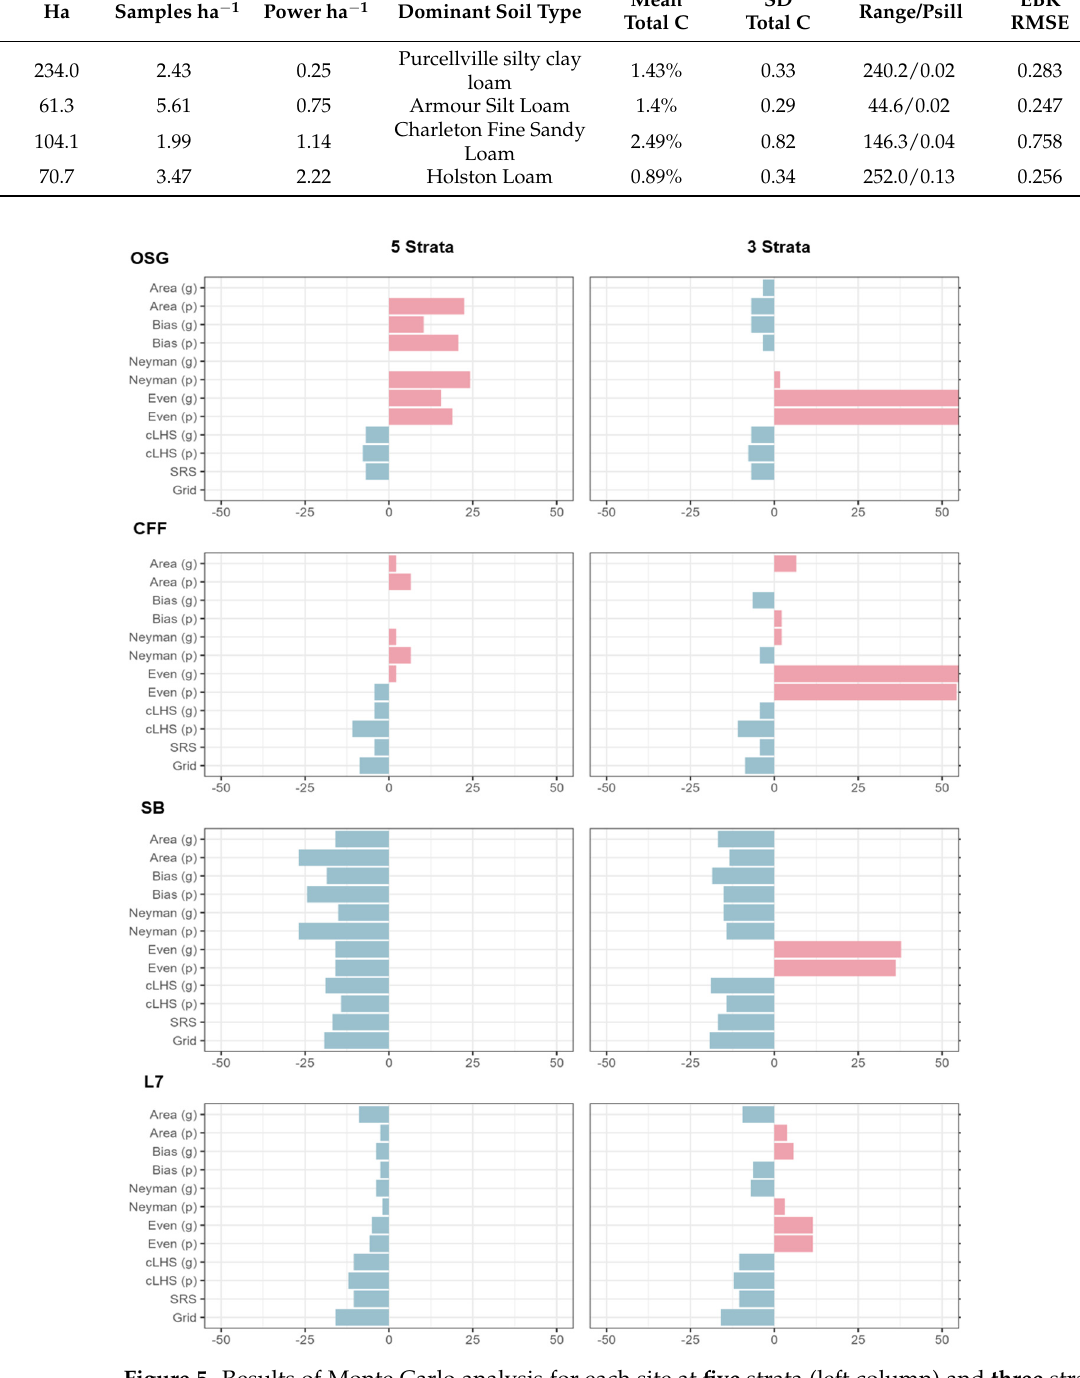
Figure 5. Results of Monte Carlo analysis for each site at five strata (left column) and three strata (right column). Blue bars indicate models that outperformed a power analysis. Red bars indicate models that underperformed the power analysis. Values are percent deviation in ideal samples from power analysis.